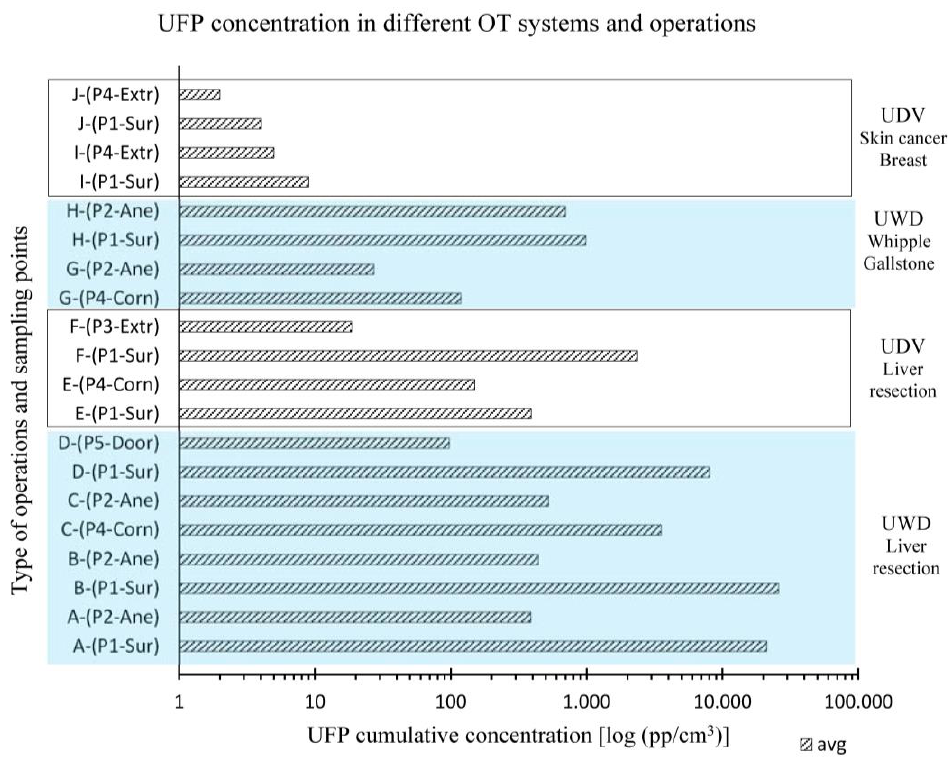
Figure 2. UFP cumulative time average concentration values vs. OT and ventilation system type (UDV or UWD), surgery activity and sampling point positions (P1-Sur to P5-Door) for different surgical activities (operations A to J).